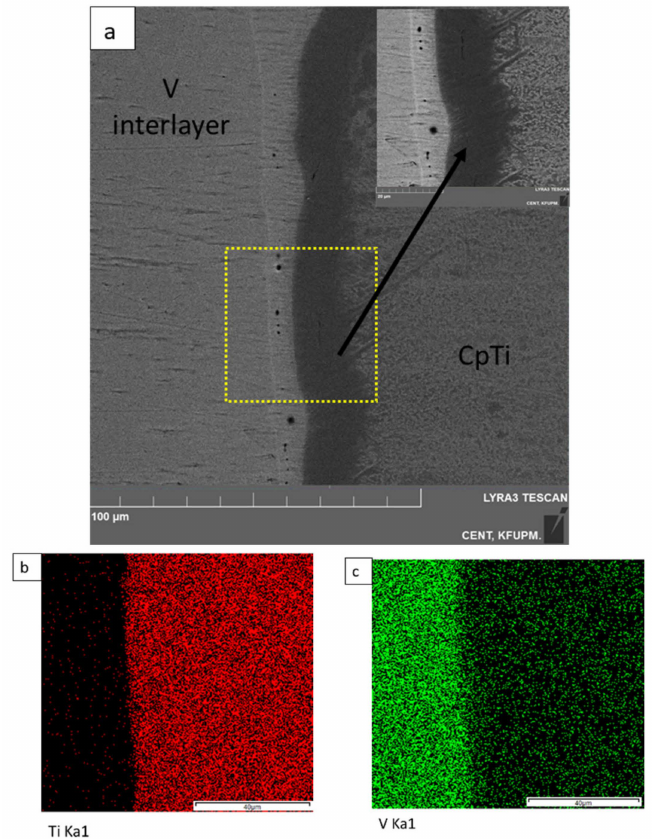
Figure 4. ( a ) Interfacial microstructures of V/CpTi interface. ( b , c ) Elemental mapping of highlighted region in ( a ).